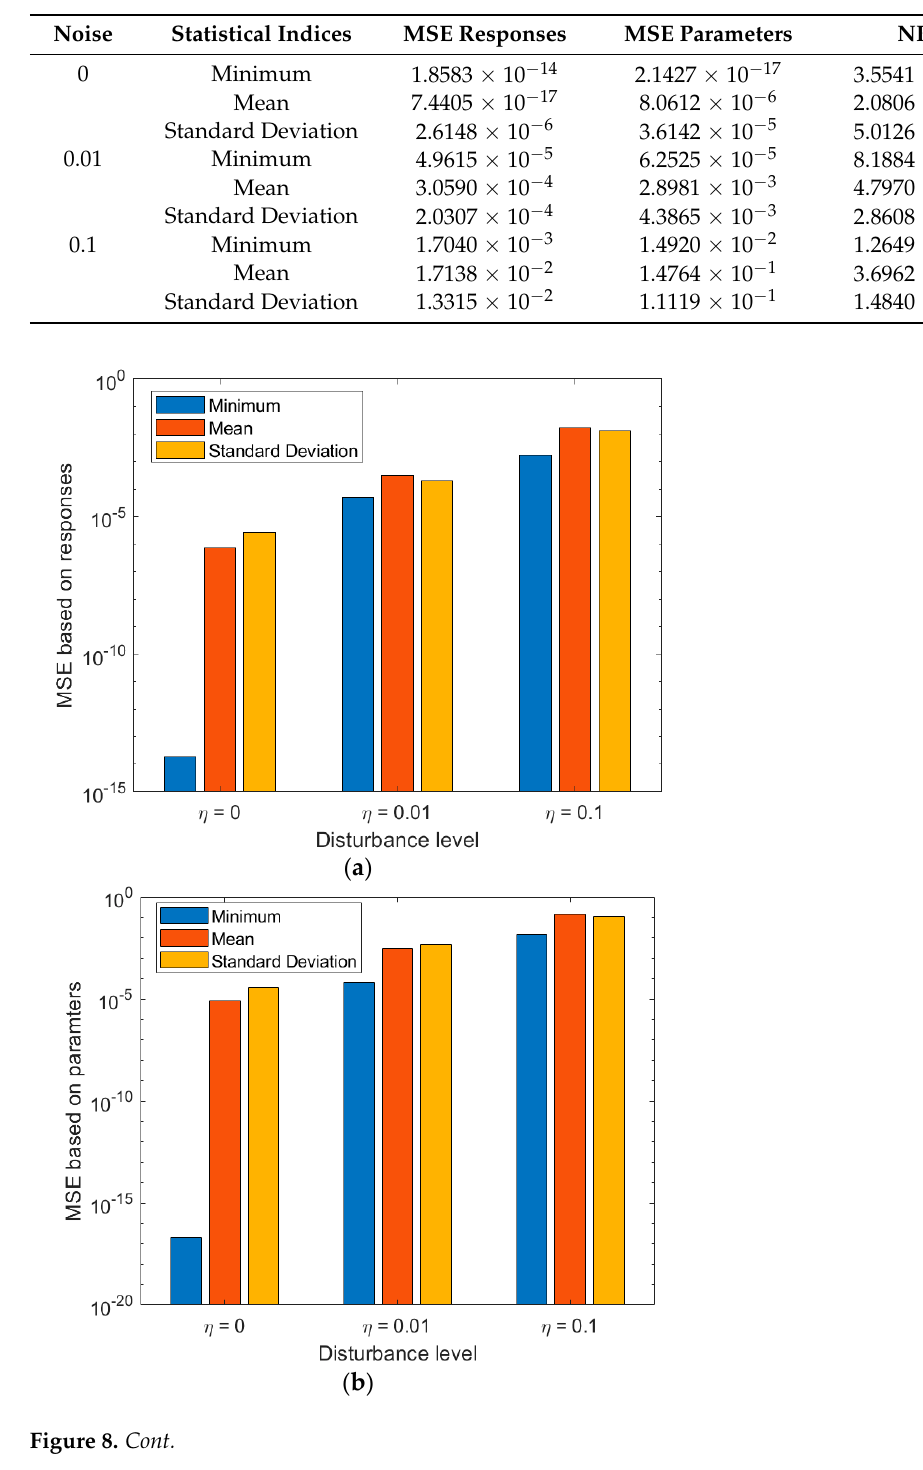
Figure 7. Result of autonomous executions in ascending order through different evaluation metrics for Problem 1. ( a ) MSE (ascending order) through estimated response ( b ) MSE (ascending order) through estimated parameters ( c ) Normalized (ascending order) parameter deviation Table 1. Results of statistical indices for different evaluation metrics in Problem 1.